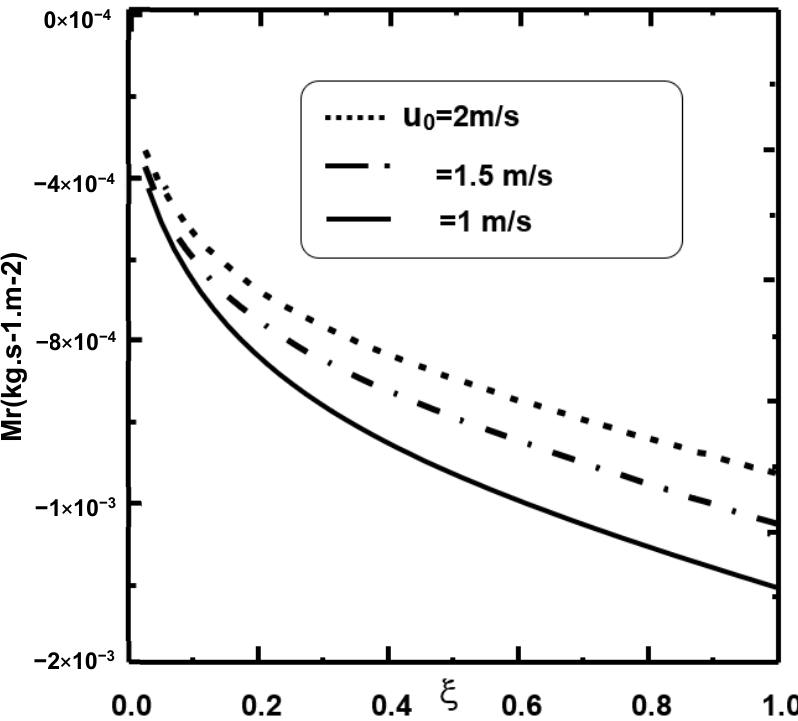
Figure 13. Effect of inlet vapor velocity on the cumulated condensation rate: T 0 =293.15 K, T 0L =293.15 K, T w =293.15 K, Φ 0 =0.03, c 0 =0.3, q 1 = − 1000 W/m 2 , m 0L =0.015 kg/m.s, H=1 m, d=0.015 m, p 0 =1 atm.